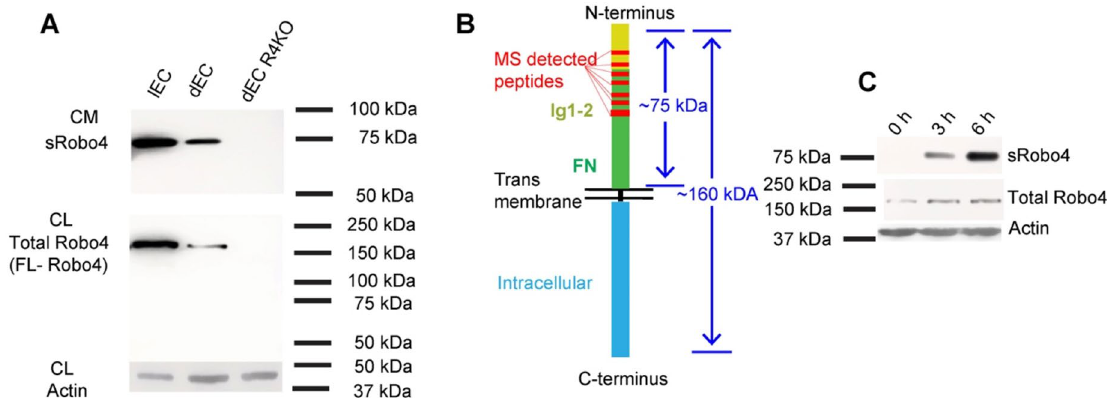
Figure 1. Robo4 ectodomain sheds constitutively. ( A ) sRobo4 was detected in conditioned media (CM) of endothelial cell culture. An antibody specific for Robo4 ectodomain detected a 75 kDa protein band in 6-h serum-free CM and a ~ 160 kDa full-length Robo4 band in the cell lysate (CL) of a wild-type mouse lung EC (lEC) line and a wildtype mouse diaphragm endothelial cell (dEC) line, but not in a Robo4 -knockout dEC (dEC- R4KO) line. ( B ) sRobo4 was detected in proteomics analysis. 10 peptide sequences of 7 regions (red strips) within the ectodomain of Robo4 were detected in the excised 75 kDa protein band in mass spectrometry